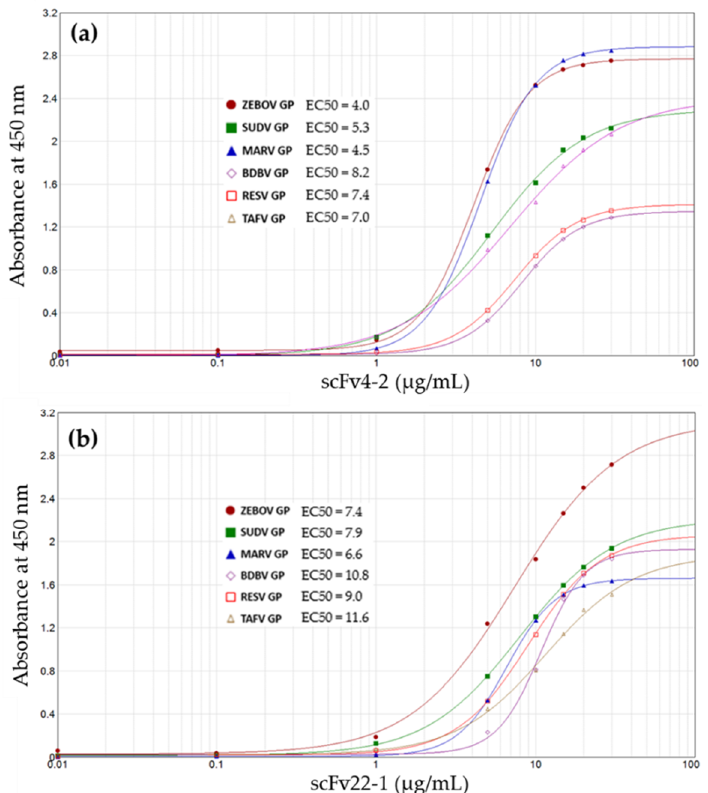
Figure 2. Pan-filovirus single-chain antibody fragments (scFvs) generated by advanced ribosomal display (adapted from Kunamneni et al. [98]). ( a , b ) ELISA dose–response curves show specific binding of pan-filovirus scFv4-2 and scFv22-1. Differential binding of these scFvs to glycoprotein (GP) from five ebolaviruses (Zaire (ZEBOV), Sudan (SUDV), Tai Forest (TAFV), Bundibugyo (BDBV), and as well as the non-pathogenic Reston (RESTV)) and one Marburg virus (MARV) was determined by a 4-parameter logistic ELISA curve [98].